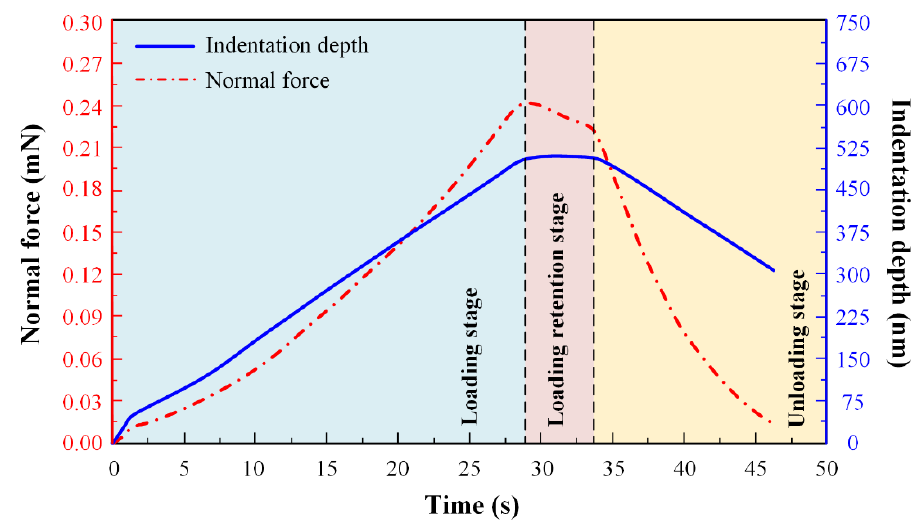
Figure 2. Indentation depth and normal force curves of nanoindentation